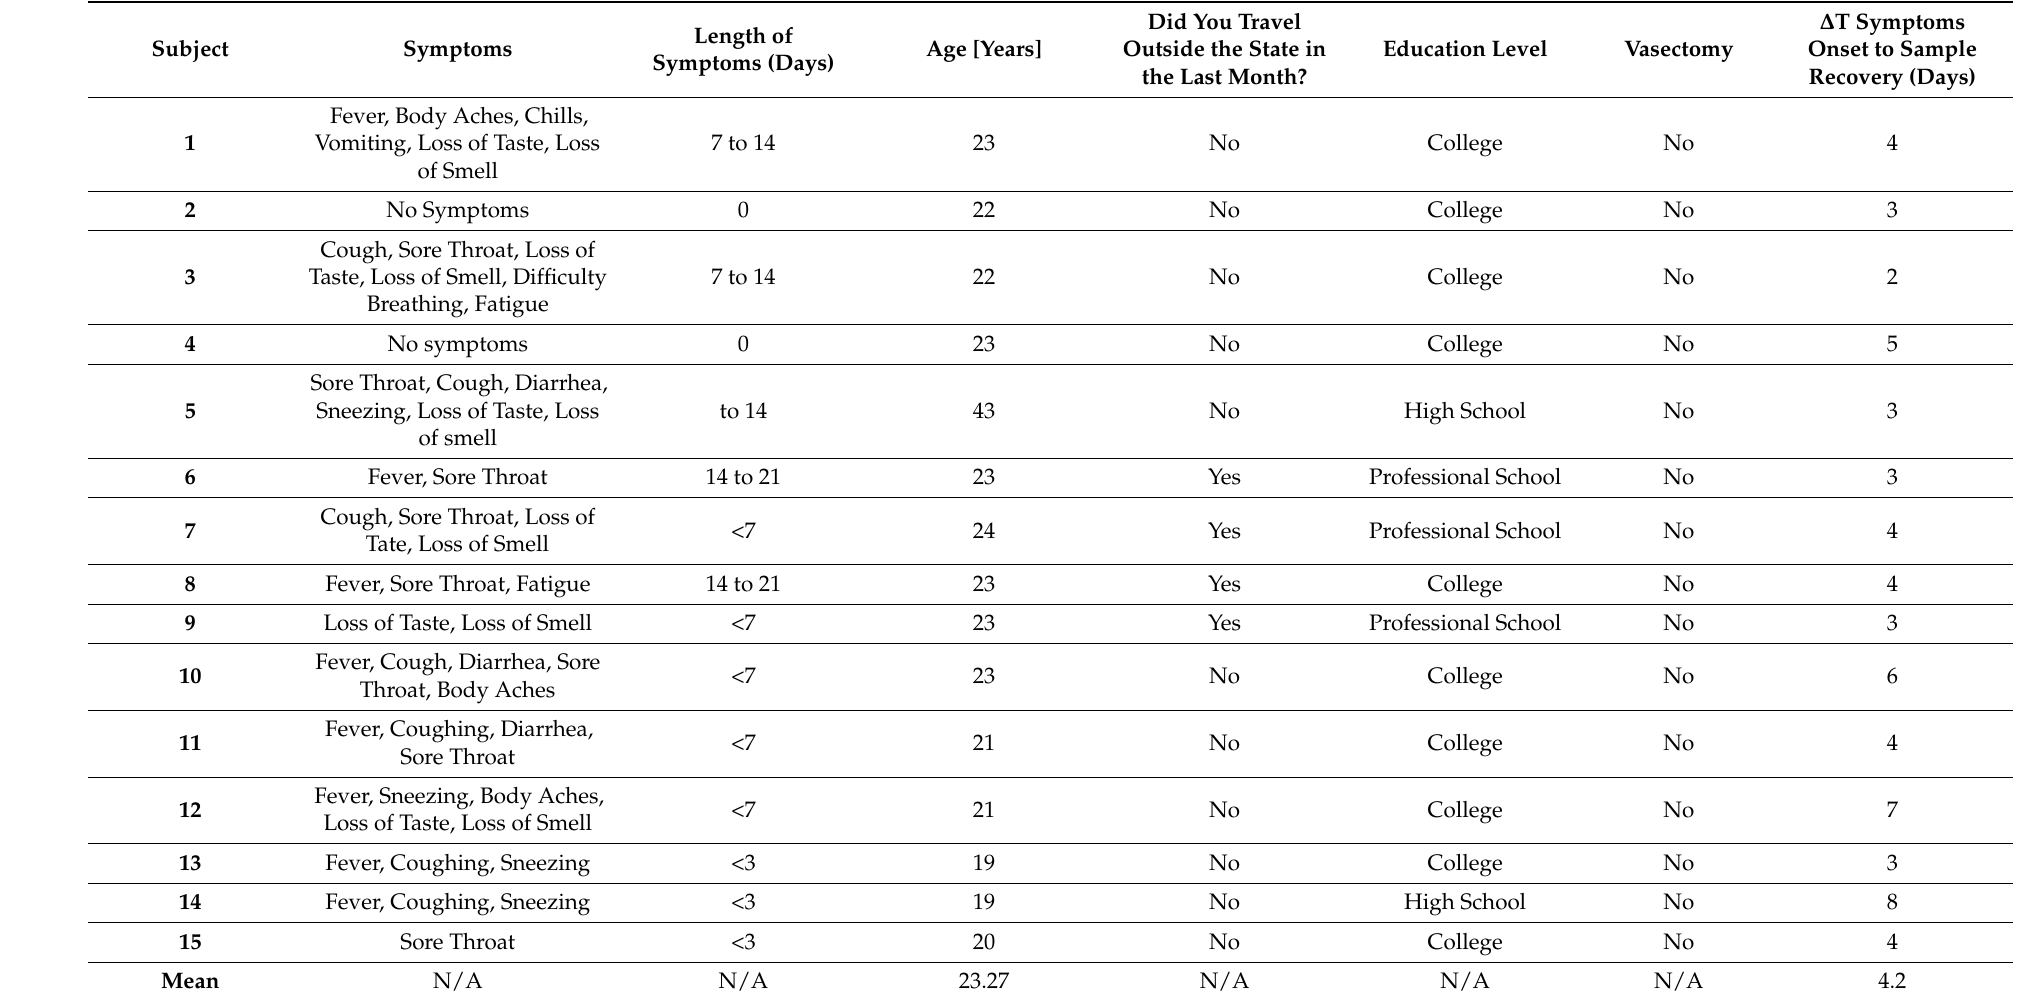
Table 1. Sample Demographics and